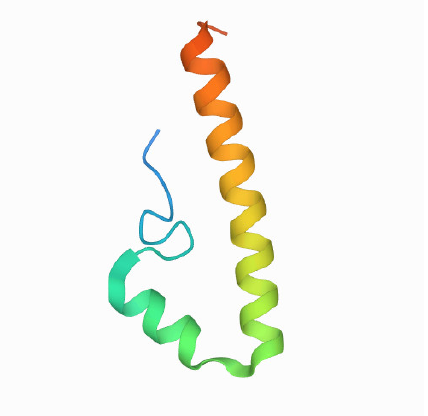
Figure 2. Cyclic molecule example (PKD2L1, Polycystin-L). Extracted from the Protein Data Bank (4GIF).